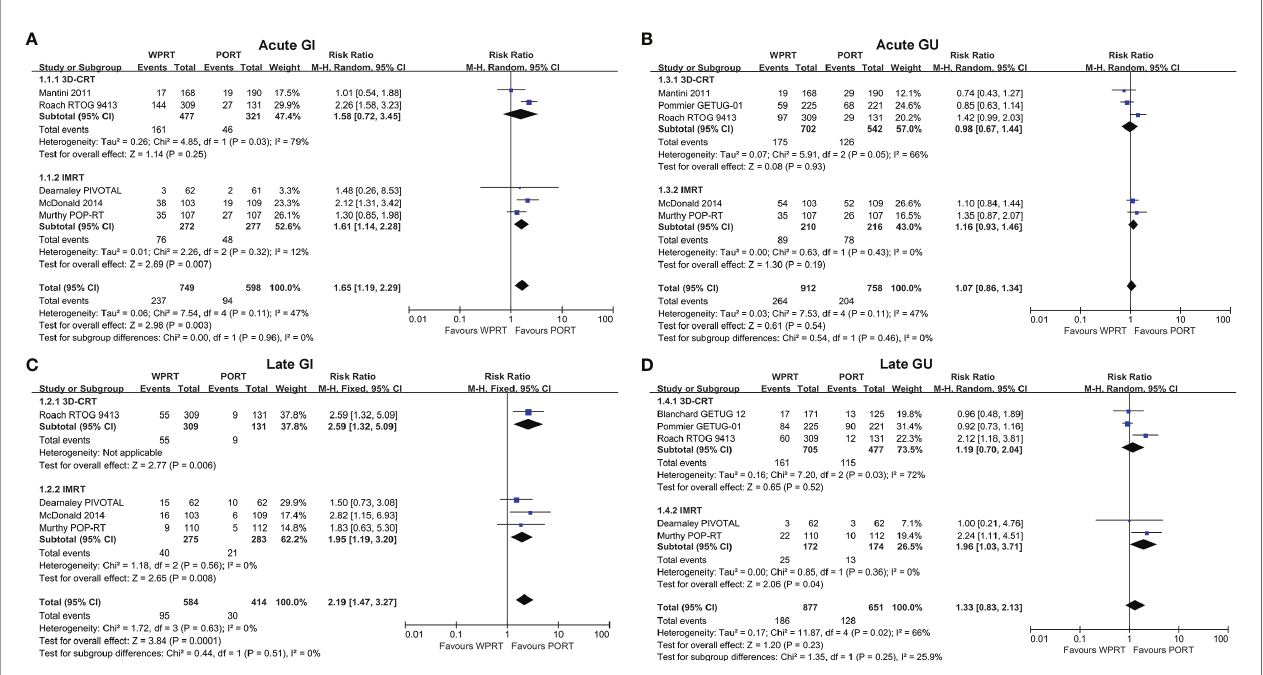
FIGURE 5 | Subgroup analysis of radiotherapy technology for non-RP studies. Acute GI (A) , Late GI (B) , Acute GU (C) , and Late GU (D) . CI, con fi dence interval; WPRT, whole-pelvic radiotherapy; PORT, prostate-only radiotherapy; GI, gastrointestinal; GU,